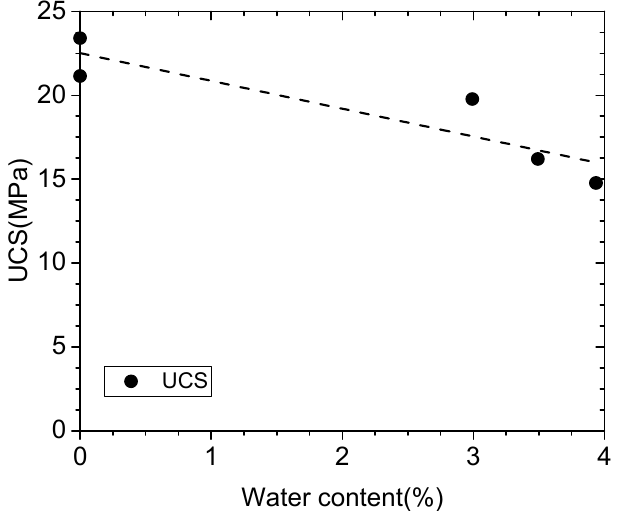
Figure 8. Variation of UCS in Beizao sandstone specimens with various water content.